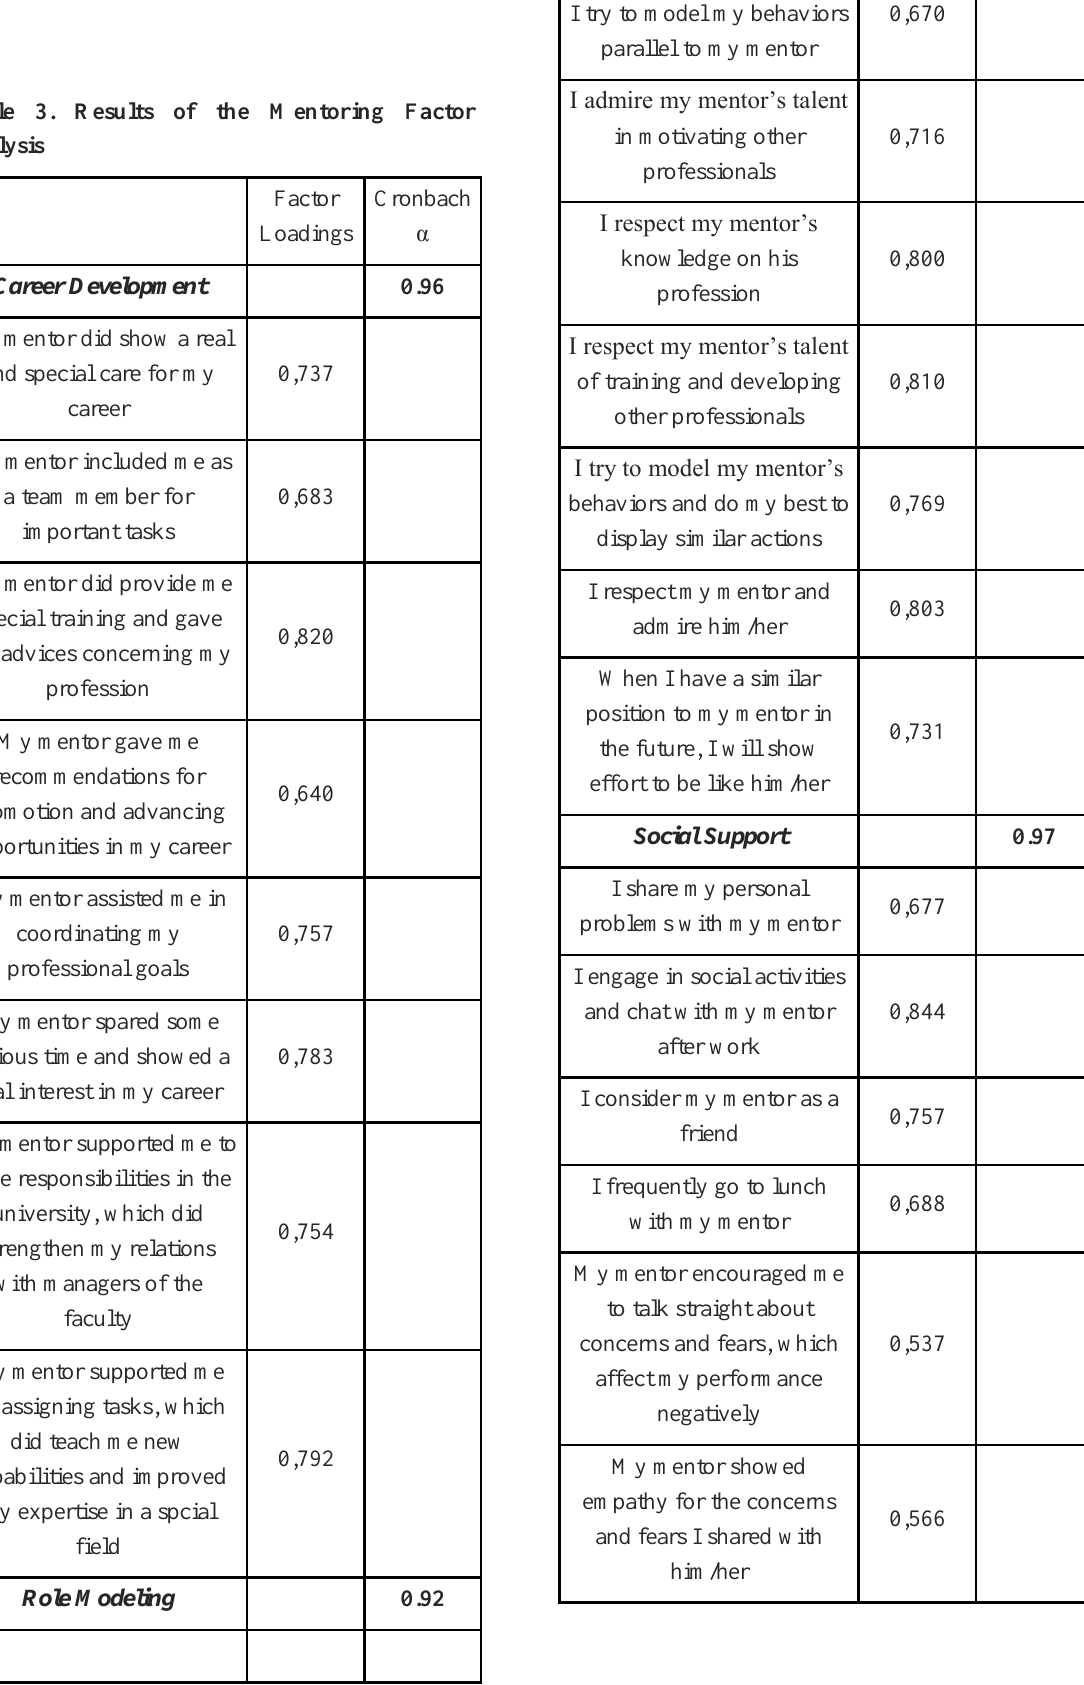
Table 3. Results of the Mentoring Factor Analysis